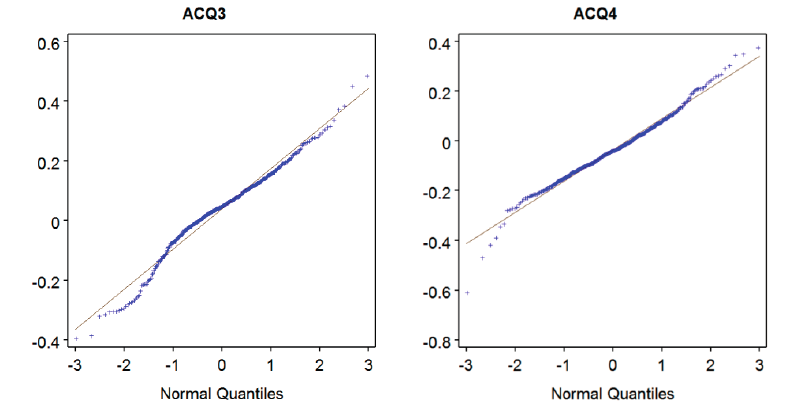
Figure 5. Normal Q-Q plot for the distribution of the individual errors ( ε ) between TIN surface elevation and ground control elevation for the four different TIN models.